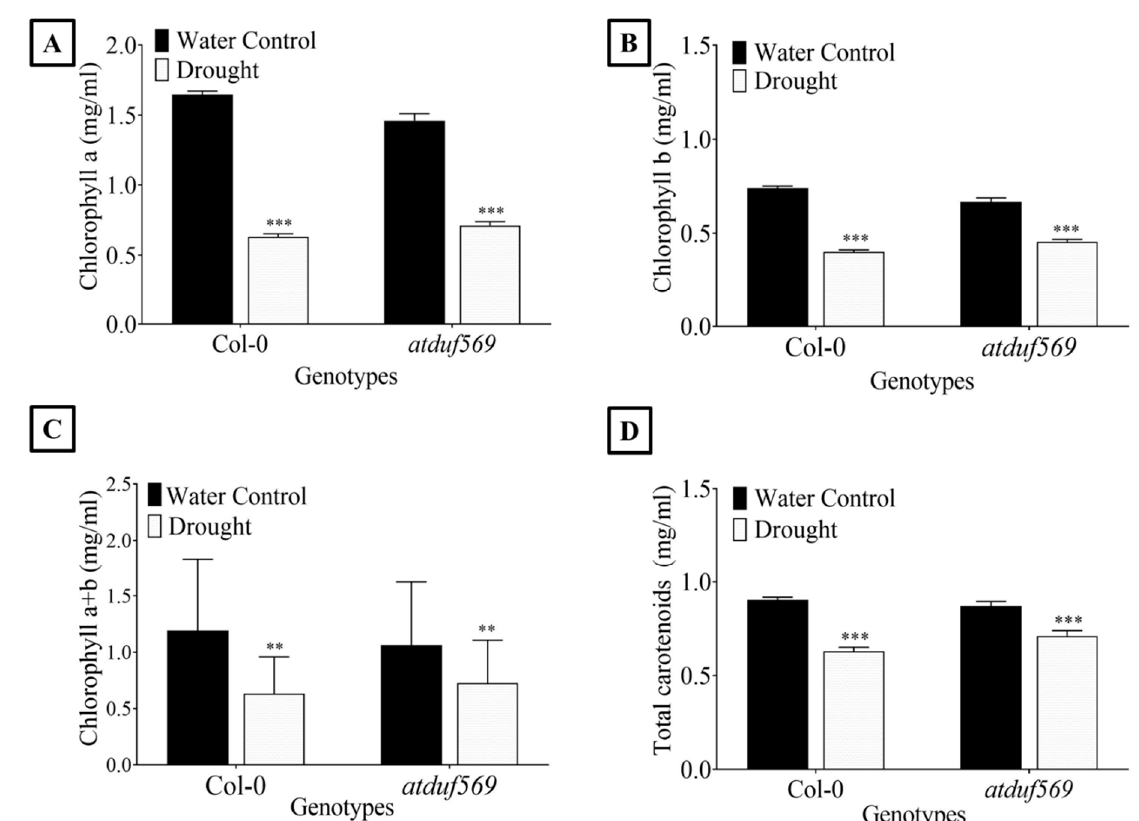
Figure 8. Total carotenoids and chlorophyll contents of WTCol-0 and atduf569 knockout mutant Arabidopsis plants under drought stress. ( A ) Total carotenoids, ( B ) chlorophyll a pigment, ( C ) chlorophyll b pigment, and ( D ) chlorophyll a + b pigment in the two Arabidopsis genotypes under the drought and control conditions. Data represent means of values obtained from experiments performed in triplicate. Error bars represent standard deviation. Means were analyzed for significant differences using Student’s t -test. Asterisks * indicate significant whereas “ns” indicate non-significant differences at 5% level of significance (*** p < 0.001, ** p < 0.01).